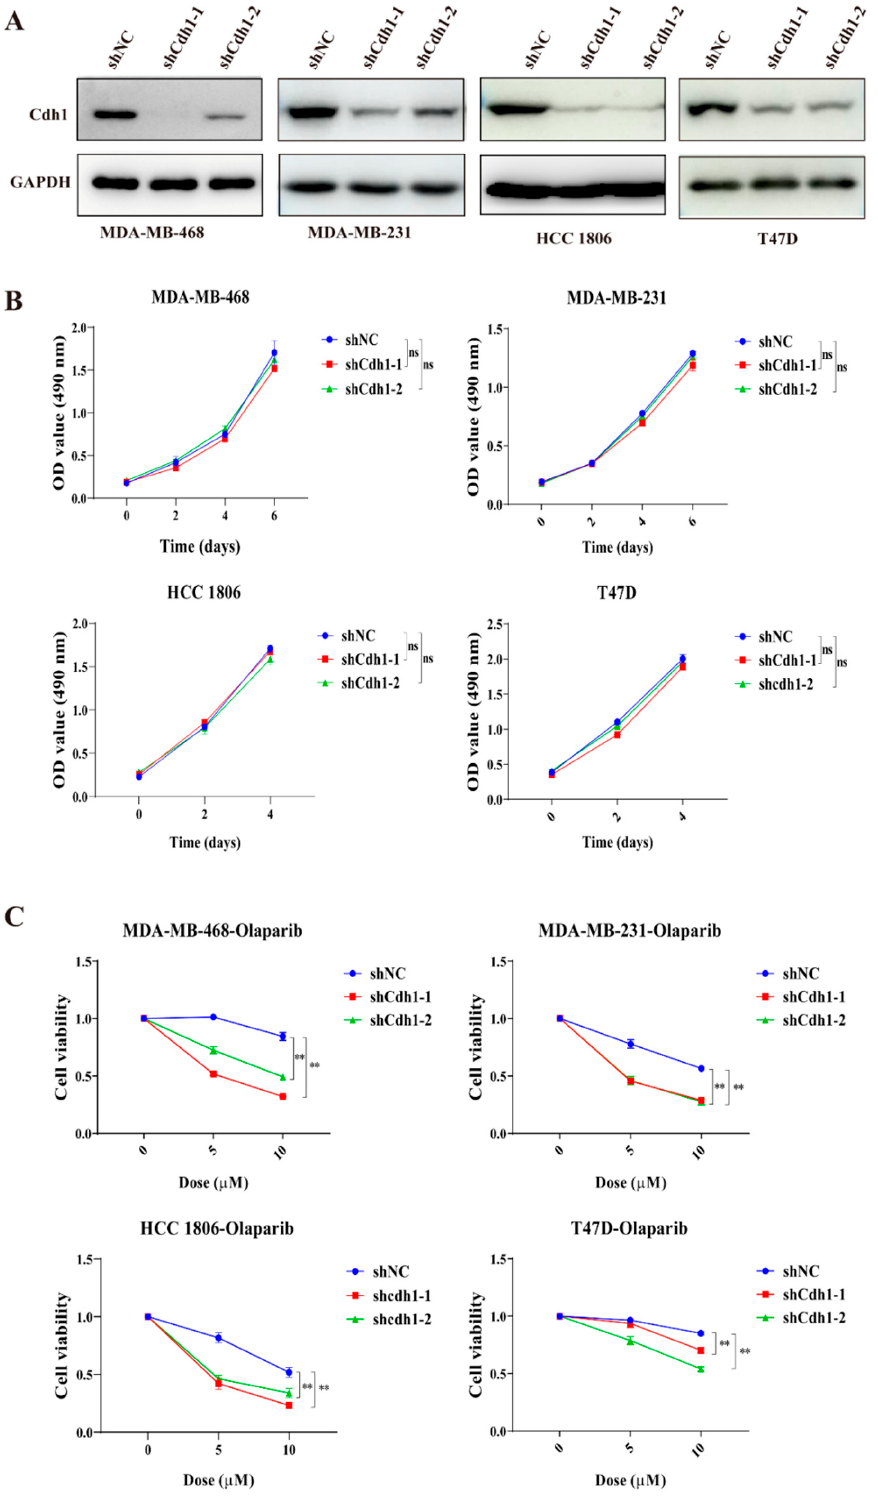
Figure 2. Cdh1 depletion sensitizes breast cancer cells to PARPi. ( A ) Western blotting analysis of